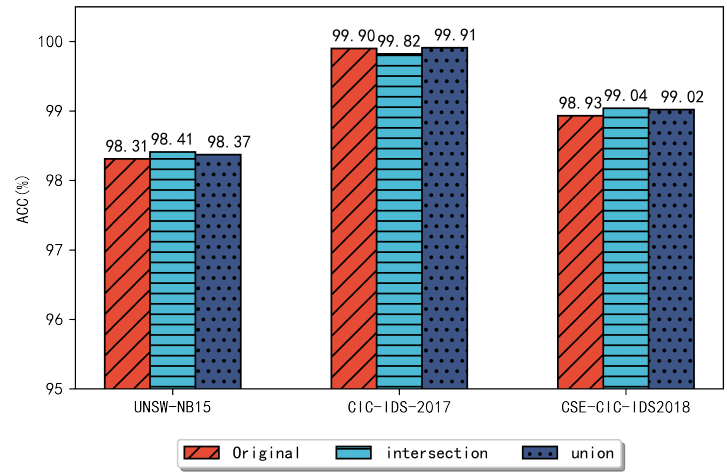
Figure 5. Using an RF classifier to compare the accuracy of several datasets.